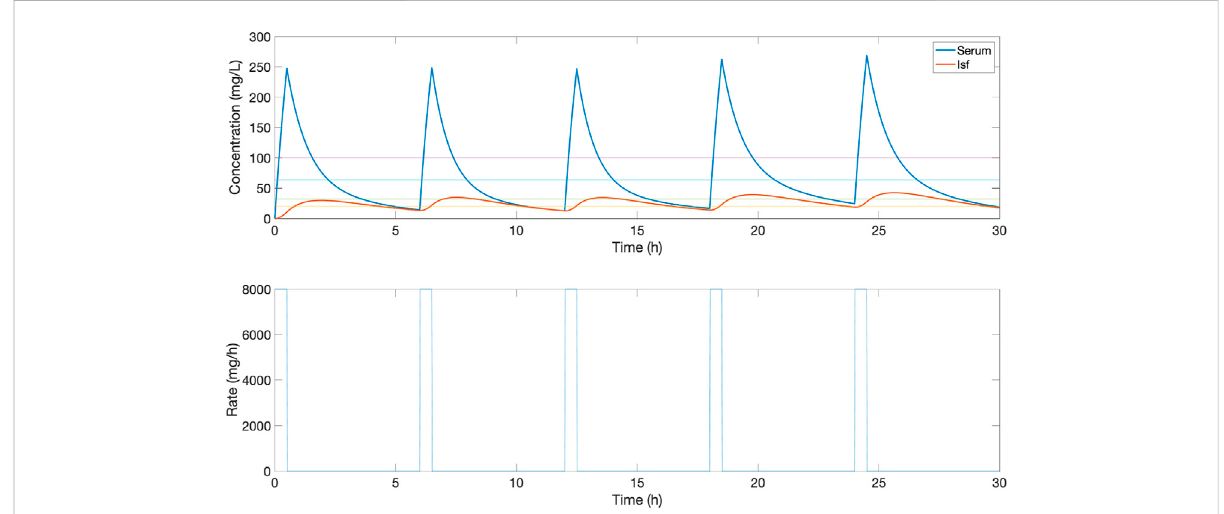
FIGURE 3 AnexampleoftheserumandISFconcentration(mg/L)ofpiperacillinandcorrespondingIVrate(mg/h)foran insilico patientdosedbyprotocol 1,astandardclinicaldosingprotocolwherebolusesof4,000 mgaredeliveredat6-hintervals.Inthispatient,thismethodprovidesalowserumtime in range, due to peaks and troughs outside the 32 – 64 mg/L target evaluation